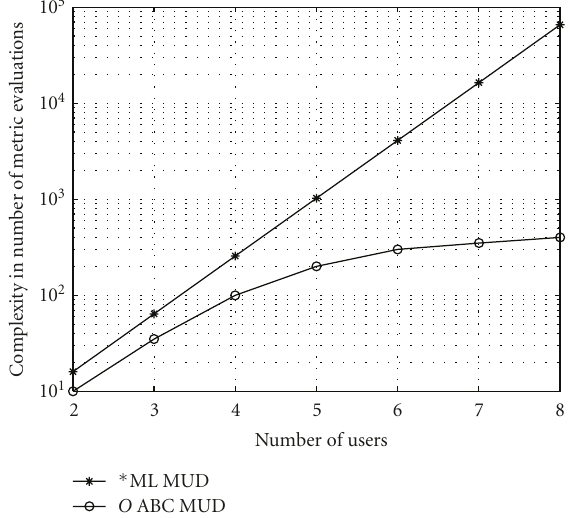
Figure 10: Performance comparison of the MUD complexity in terms of the number of metric evaluations, versus the number of